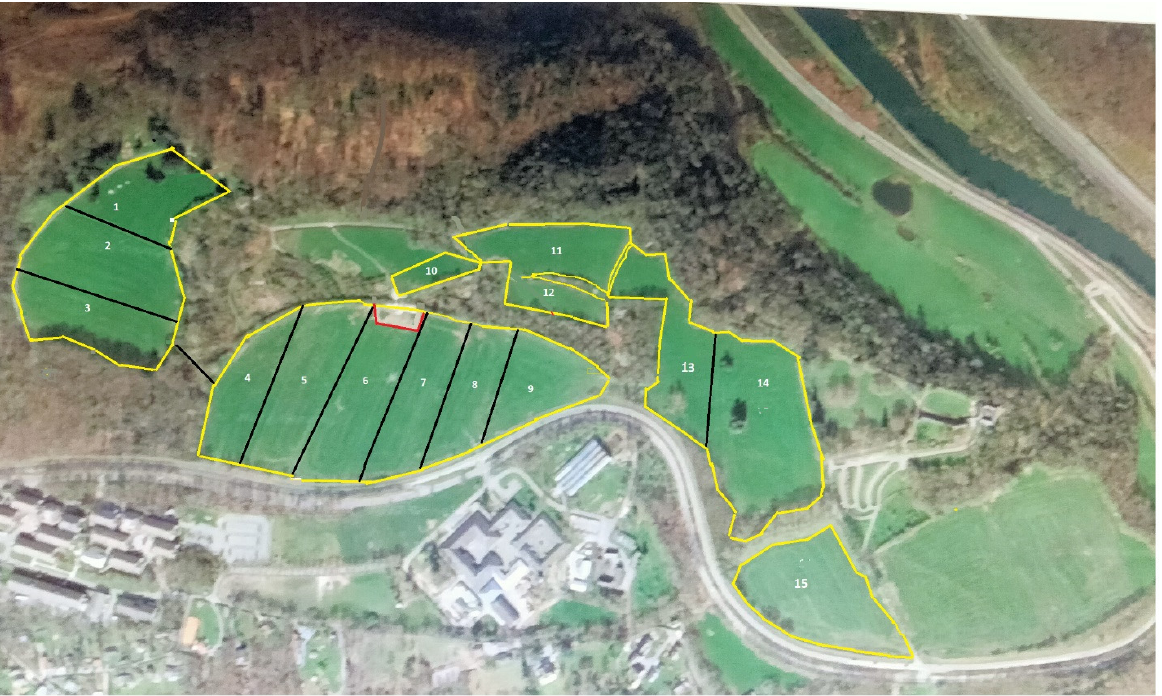
Table 1. Characteristics of the group at the beginning of the trial. Values are means ± standard de- viation.